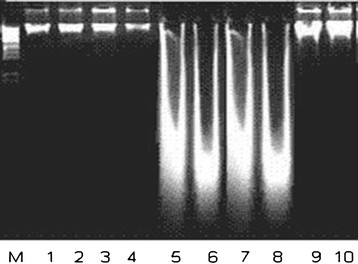
Agarose gel showing DNA damage by CCl4and preventive effect of chloroform extract ofLaunaea procumbensshowing that Lanes (from left) DNA marker (M), control (1-4), CCl4(5, 8), 200 mg/kg b.w., LPCE + CCl4(9, 10).